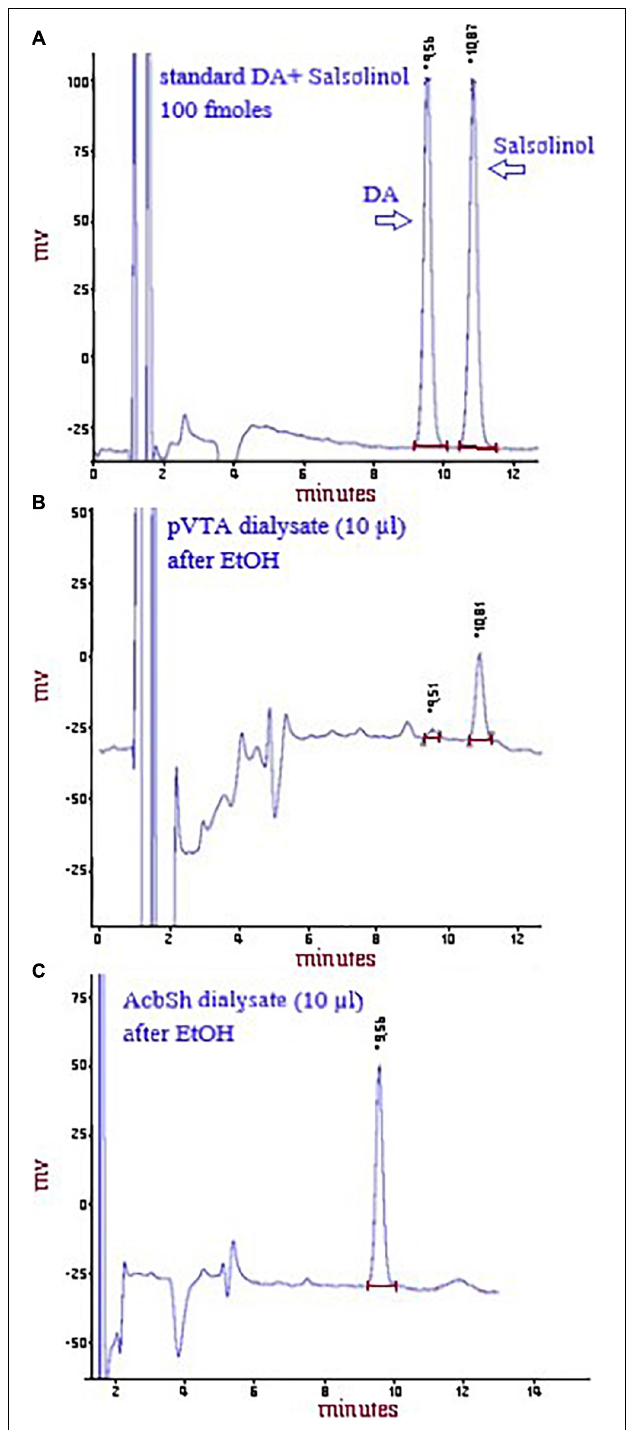
FIGURE 1 | Representative chromatograms showing the peaks of DA and salsolinol after the HPLC injection of a standard solution of 100 fmol of both DA and salsolinol/10 µ l (A) or of DA and salsolinol after the HPLC injection of a pVTA dialysate (10 µ l) from a rat administered ethanol (B) or of DA, but not salsolinol (see sections “Materials and Methods” and “Discussion” and Zimatkin and Lindros, 1996) after the HPLC injection of an AcbSh dialysate (10 µ l) from a rat administered ethanol (C)